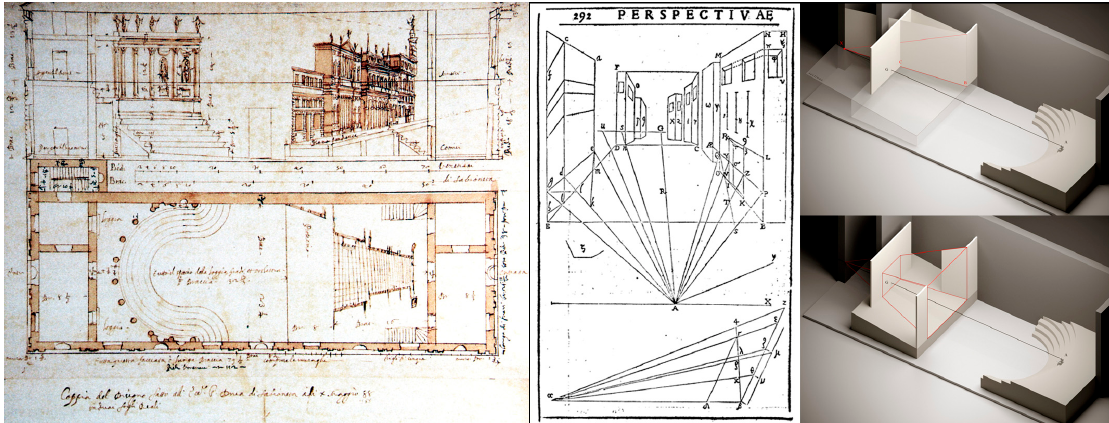
Figure 2. Left : Vincenzo Scamozzi’s drawing for the scenography of the Theatre in Sabbioneta; Right : construction of the scenography in De Scenis treatise by Guidobaldo del Monte,